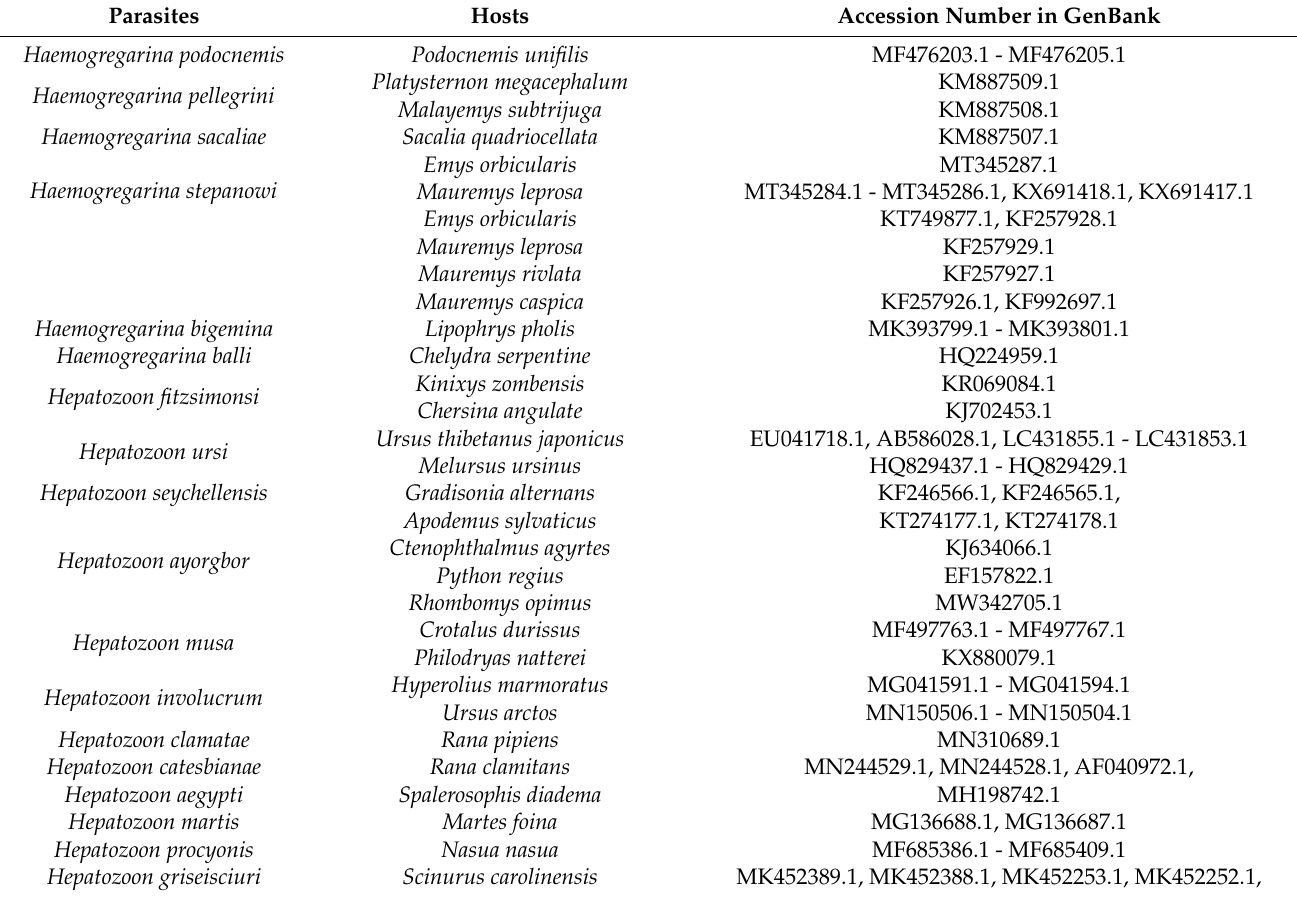
Table 11. List of sequences for haemogregarines from GenBank database based on the 18S rRNA gene.